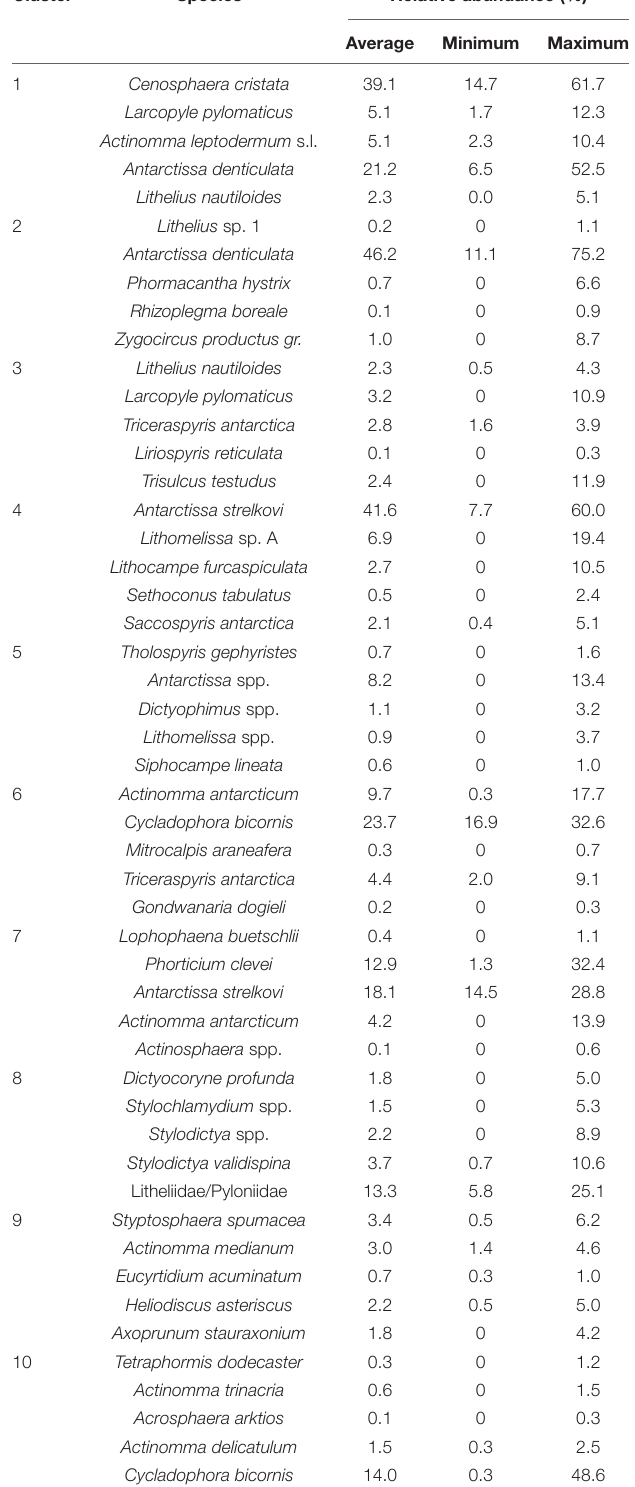
sites that are located near frontal boundaries were clustered by MRT analysis with the adjacent zone, rather than its allocated zone according to the Orsi fronts ( Figure 4 ; Orsi et al., 1995). This could be related to the dynamic nature of hydrological fronts. The single mean position of the fronts does not display the extent of frontal shifts, and is therefore considered a guide only for oceanographic